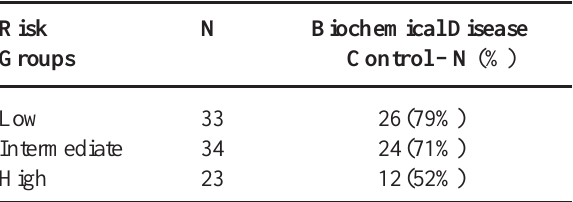
Table 1 – Biochemical disease control according the risk